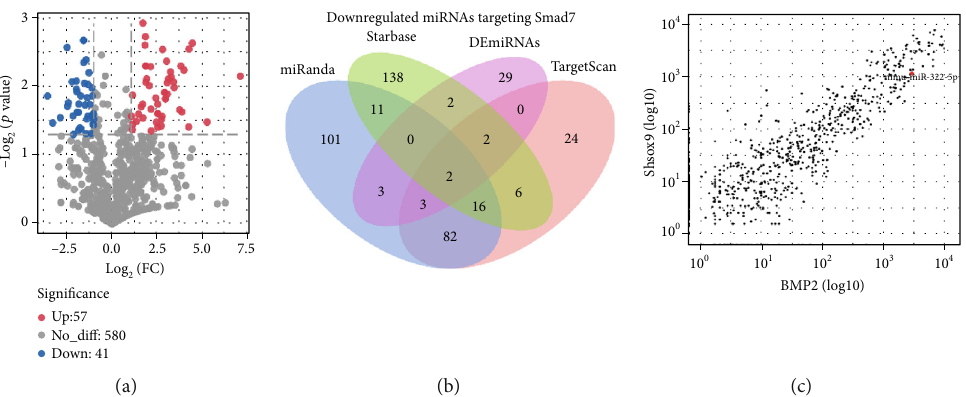
Figure 2: The NGS and bioinformatic analysis demonstrated that silencing of Sox9 decreased the expression of miR-322-5p which was predicted to target Smad7. (a) The volcano plot showed the upregulated and downregulated miRNAs in the BMP2+shSox9 group. (b) The Venn diagram analysis revealed that only two downregulated miRNAs, including miR-322-5p, appeared in all three databases. (c) The correlation coe ffi cient between groups was 0.9, and miR-322-5p was marked. FC: fold change.